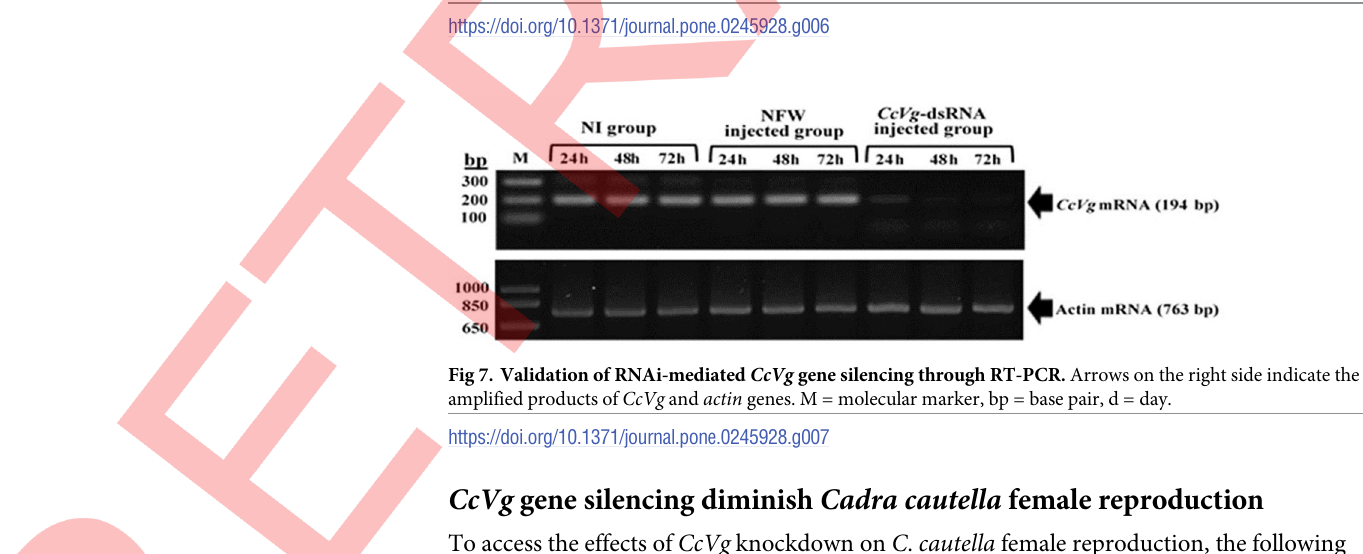
Fig 6. RNAi-mediated silencing of the CcVg gene. Different letters above the bars (a, b) show significant differences between the treatment groups ( α = 0.05). The bars represent normalized fold expression (mean ± SE).